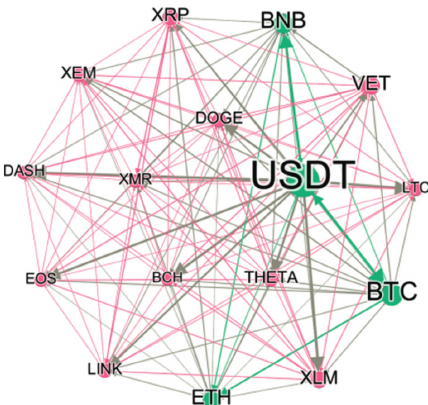
Figure 28: Risk spillover under D3.